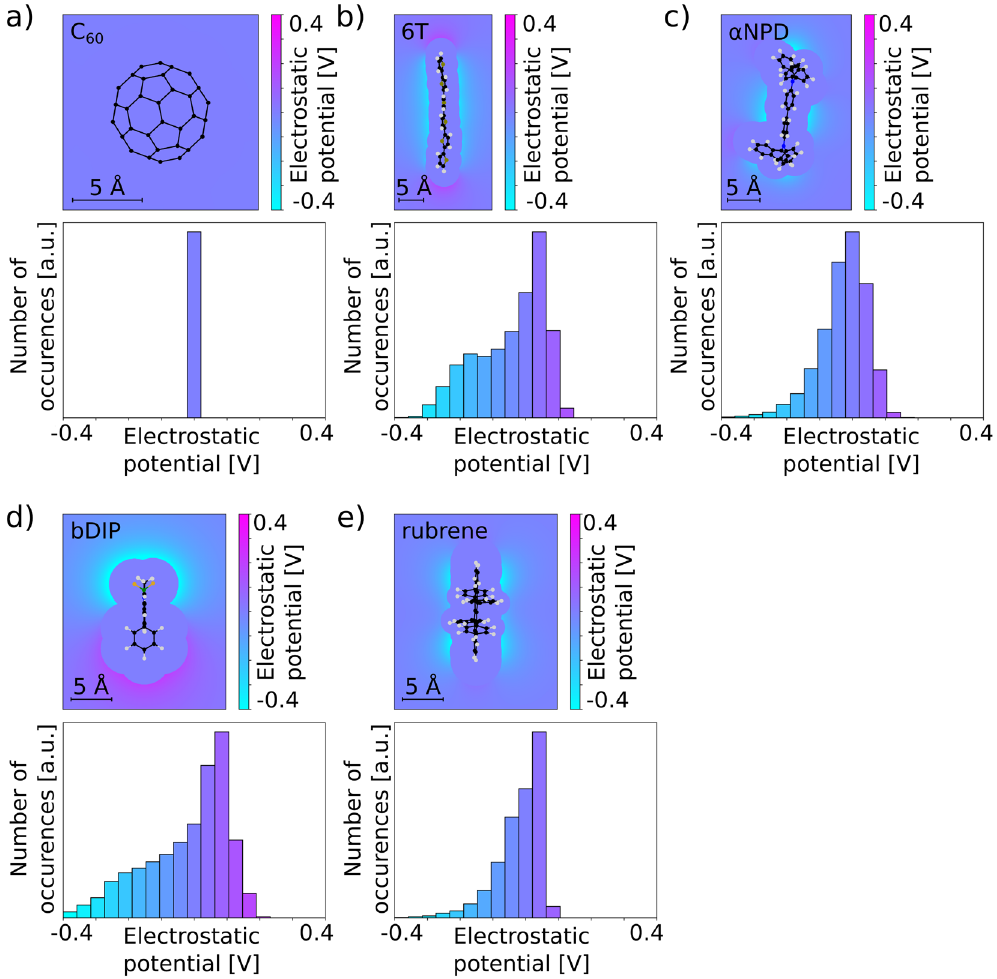
Figure 3. The panels show the electrostatic potential caused by the charge density of the molecules as well as histograms of the electrostatic potential. The planes on which the electrostatic potential is plotted include the points of highest potential. The histogram includes points in distances between 3.2 Å and 4.6